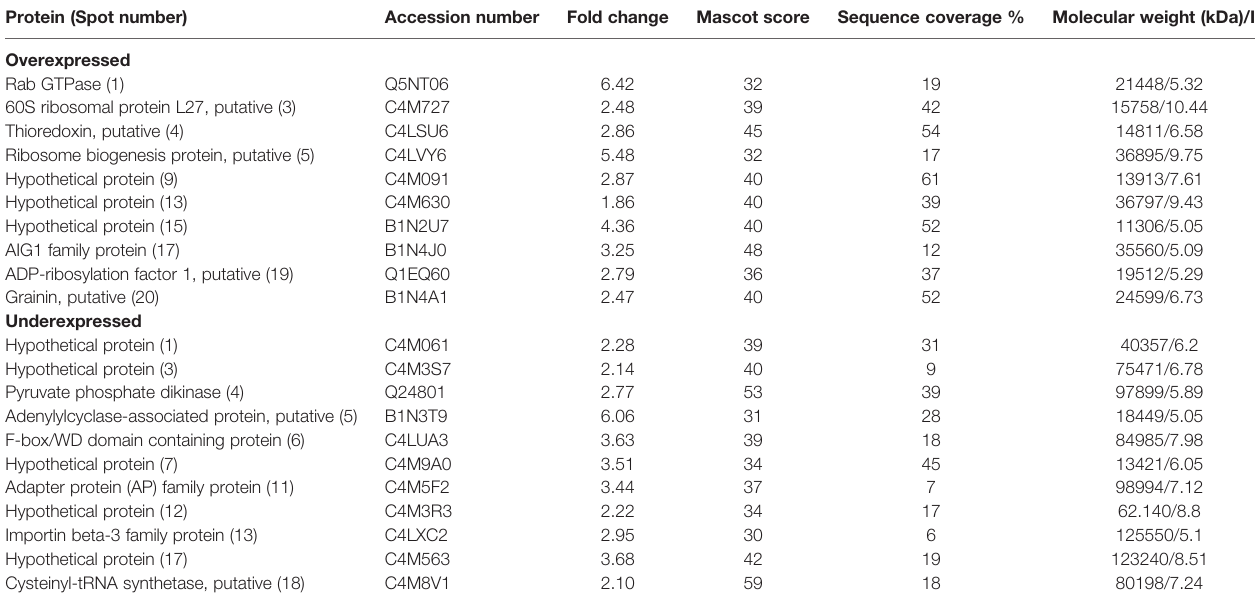
TABLE 2 | Identi fi cation of E. histolytica proteins that are modulated by QdNO T-017. Protein (Spot number)